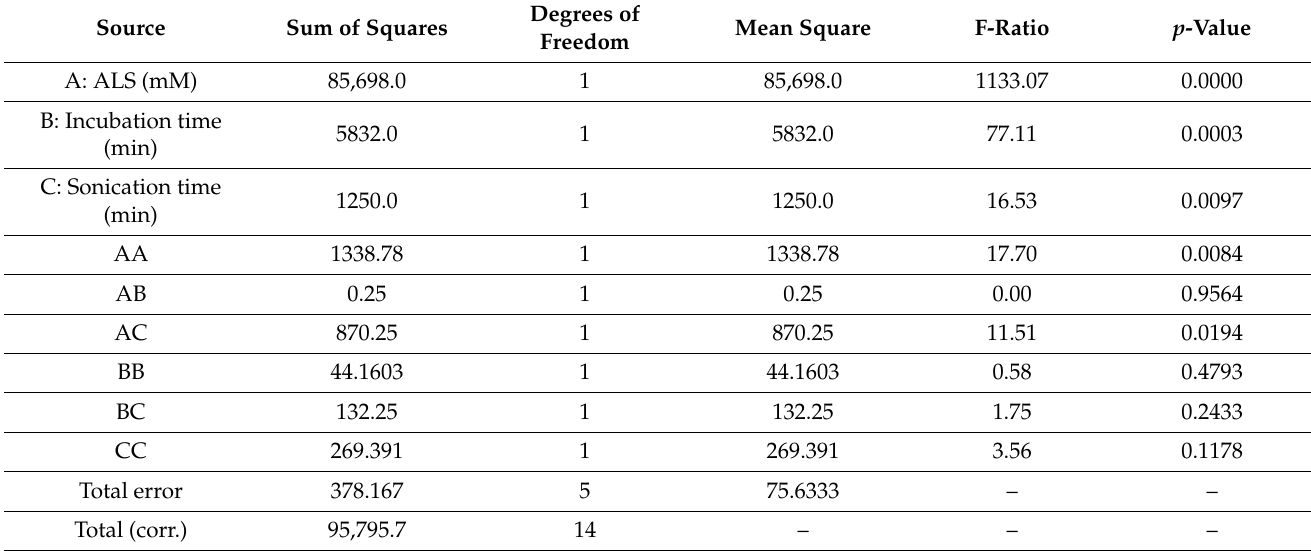
Table 2. ANOVA data for particle size of APA-ALS-NC